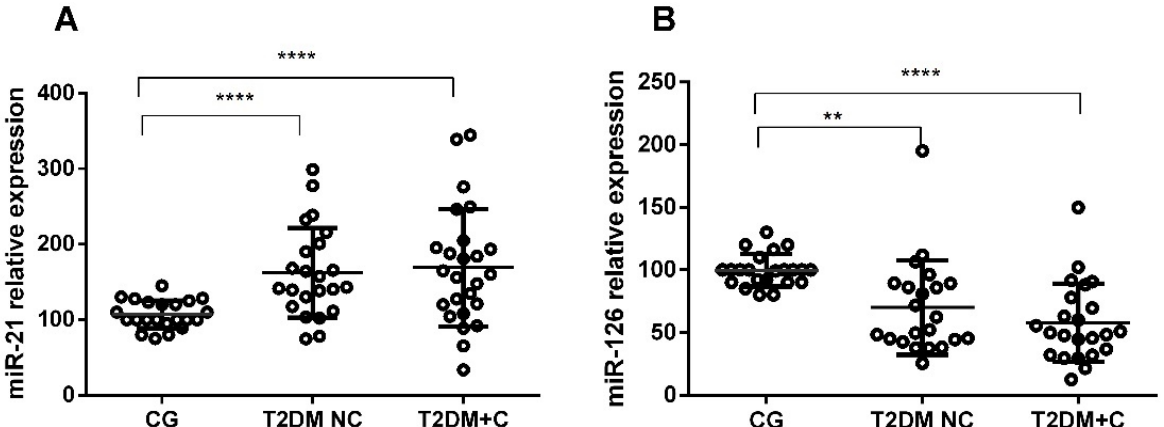
( p < 0.05) (Figure 2C,D).